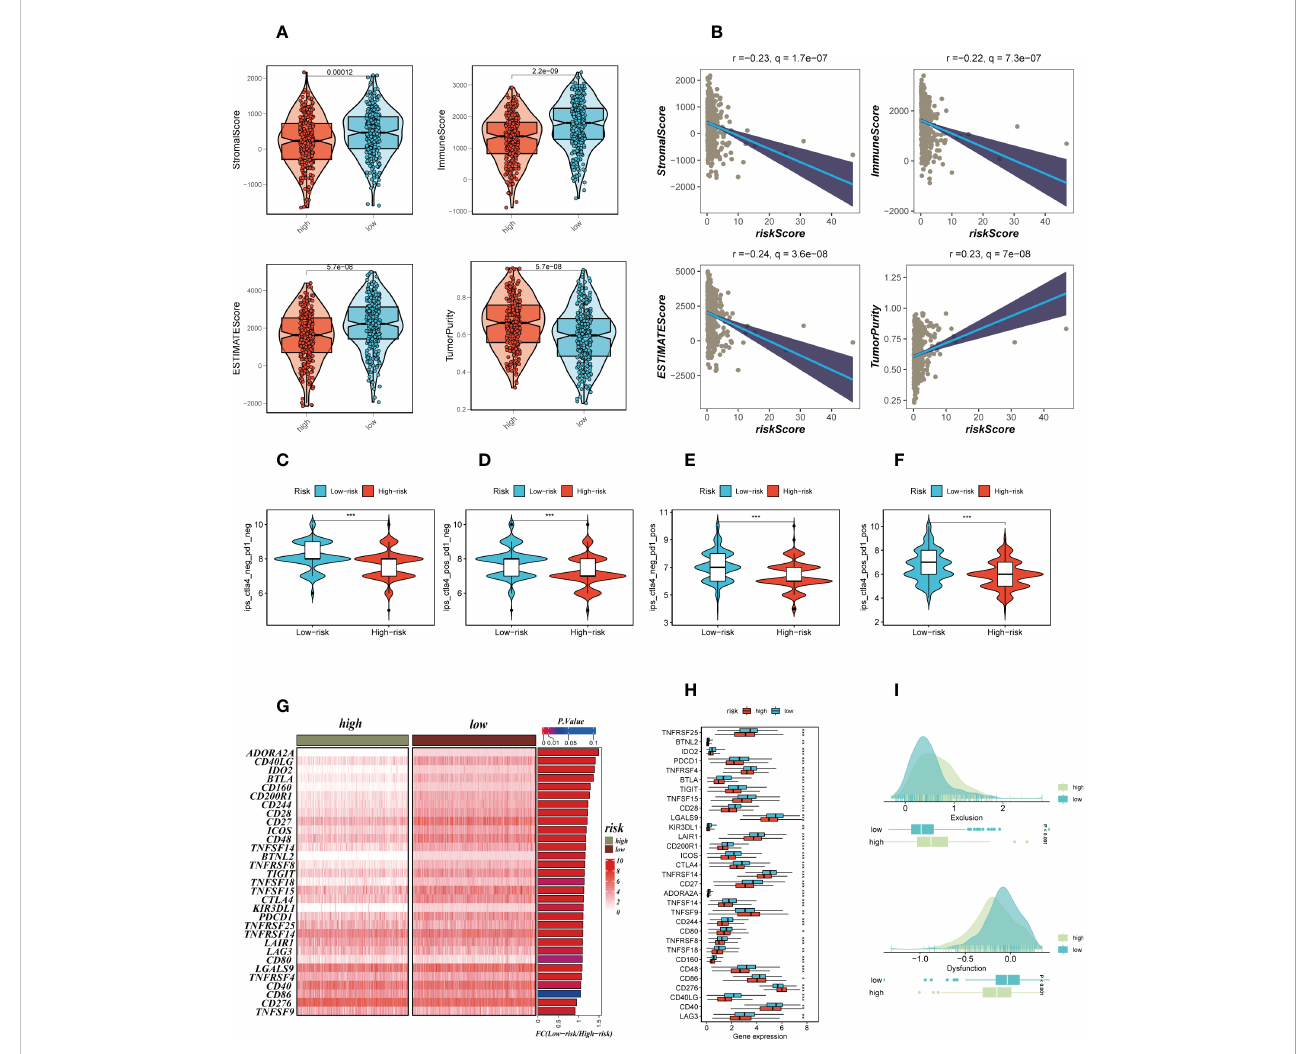
FIGURE 8 Analysis of TIME and immune checkpoint. (A) The violin plot demonstrated the difference in ESTIMATE Score, Immune Score, Stromal Score and tumor purity calculated using the ESTIMATE algorithm between the two risk subgroups. (B) The correlations in ESTIMATE Score, Immune Score, Stromal Score and tumor purity calculated using the ESTIMATE algorithm between the two risk subgroups. (C – F) The low-risk group has signi fi cantly greater IPS, IPS- CTLA4-neg-PD-1-neg, IPS-CTLA4-pos-PD-1-neg, IPS-CTLA4-neg-PD-1-pos, and IPS-CTLA4-pos-PD-1-pos. Note: * P < 0.05, ** P < 0.01, *** P < 0.001. (G, H) Heat map and box plot showed that differences in immune checkpoint gene expression between high- and low-risk subgroups. (I) TIDE between those LUAD patients at high-and low-risk